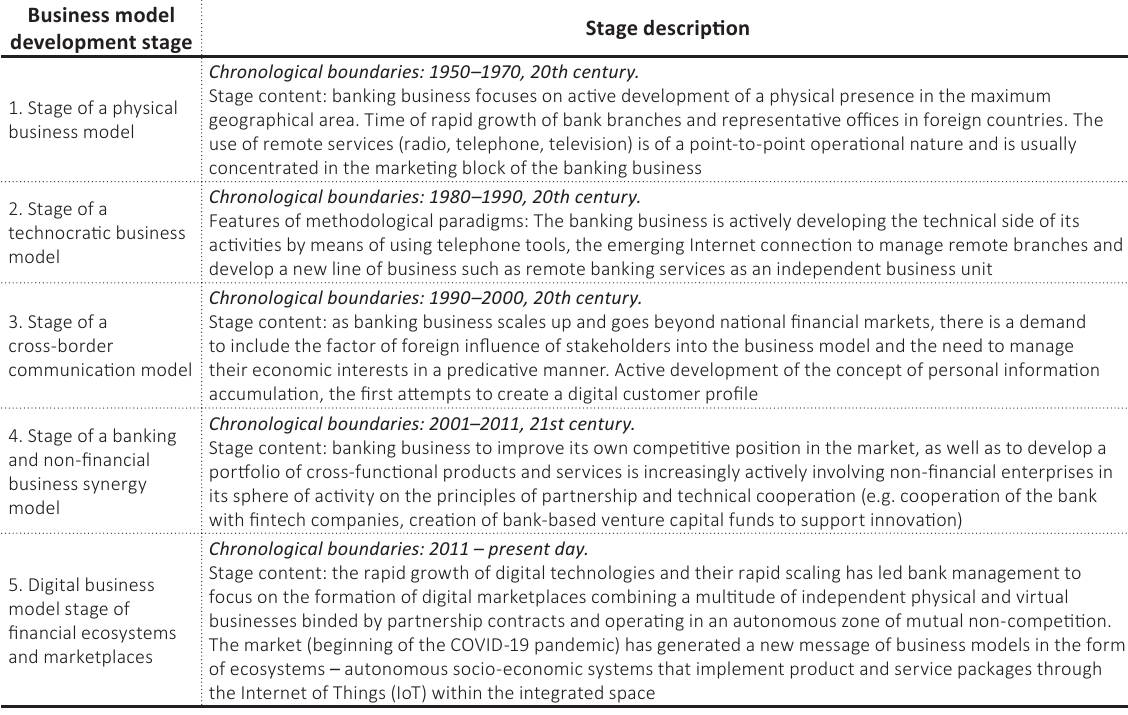
Table А1. Key stages in the digitalization evolution of banking business models